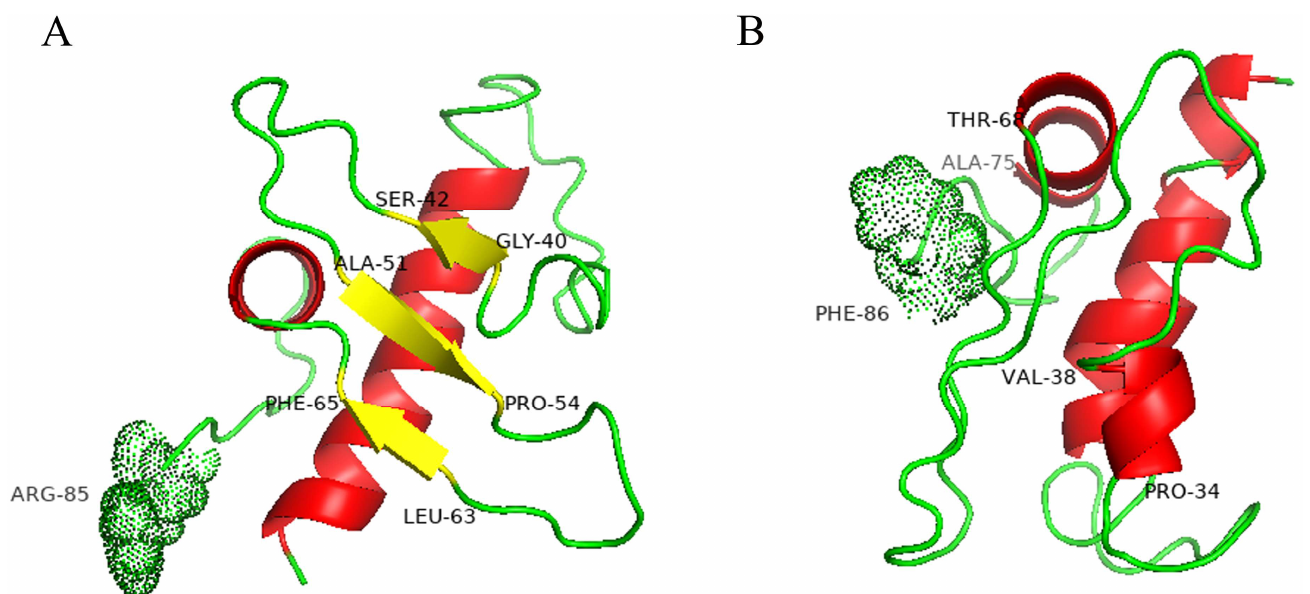
Figure 5. The 3D simulation structures of original α-MAT signal peptide ( A ) and P1’-modified α-MAT signal peptide ( B ).